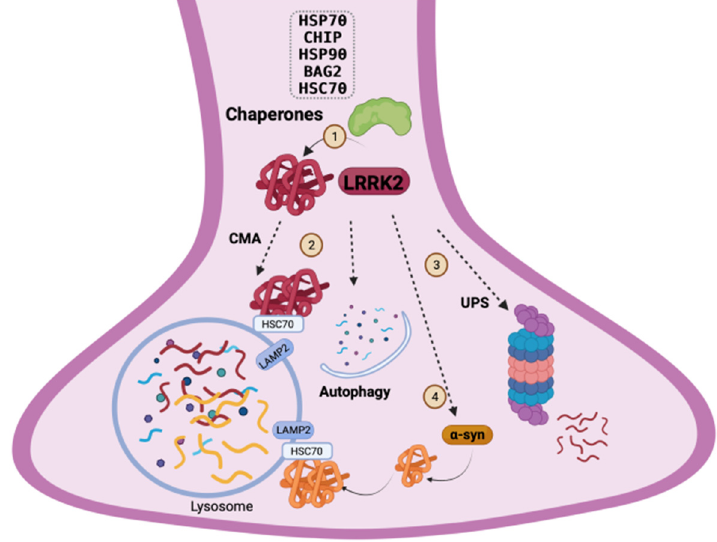
Figure 2. LRRK2 homeostasis and quality-control mechanisms. There are several approaches to control LRRK2 homeostasis: chaperone system (1), chaperone-mediated autophagy (CMA) and macroautophagy (2) and the ubiquitin–proteasome system (UBP) (3). LRRK2 dysregulation contributes to α -synuclein ( α -syn) aggregation (4), which is also recognized as CMA substrate.